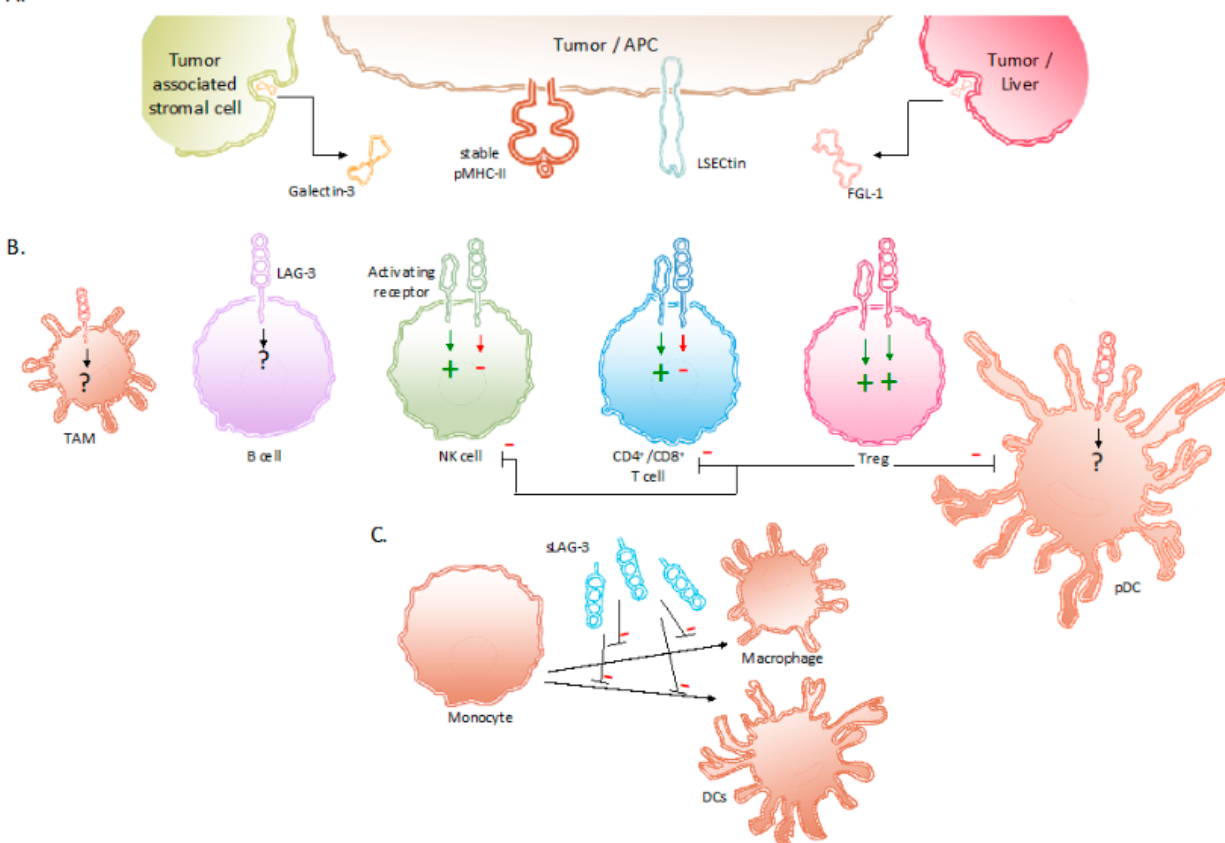
Figure 1. Expression of LAG-3 and its ligands in the TME. ( A ) Binding partners reported to associate with LAG-3 are stable pMHC-II complexes, Gal-3, LSECtin and FGL-1. These LAG-3 ligands are expressed on APCs, tumor cells and tumor-associated stromal cells. ( B ) Expression of LAG-3 on different immune cells and its influence on their effector functions. ( C ) sLAG-3 inhibiting the differentiation of monocytes towards macrophages or DCs. Abbreviations: APC, antigen-presenting cell; FGL-1, fibrinogen-like protein 1; Gal-3, Galectin-3; LSECtin, liver sinusoidal endothelial cell lectin; NK, natural killer; pDC, plasmacytoid dendritic cell; pMHC-II, peptide major histocompatibility complex class II; sLAG-3, soluble LAG-3; TAM, tumor-associated macrophage; TME, tumor microenvironment; Treg, regulatory T cell.